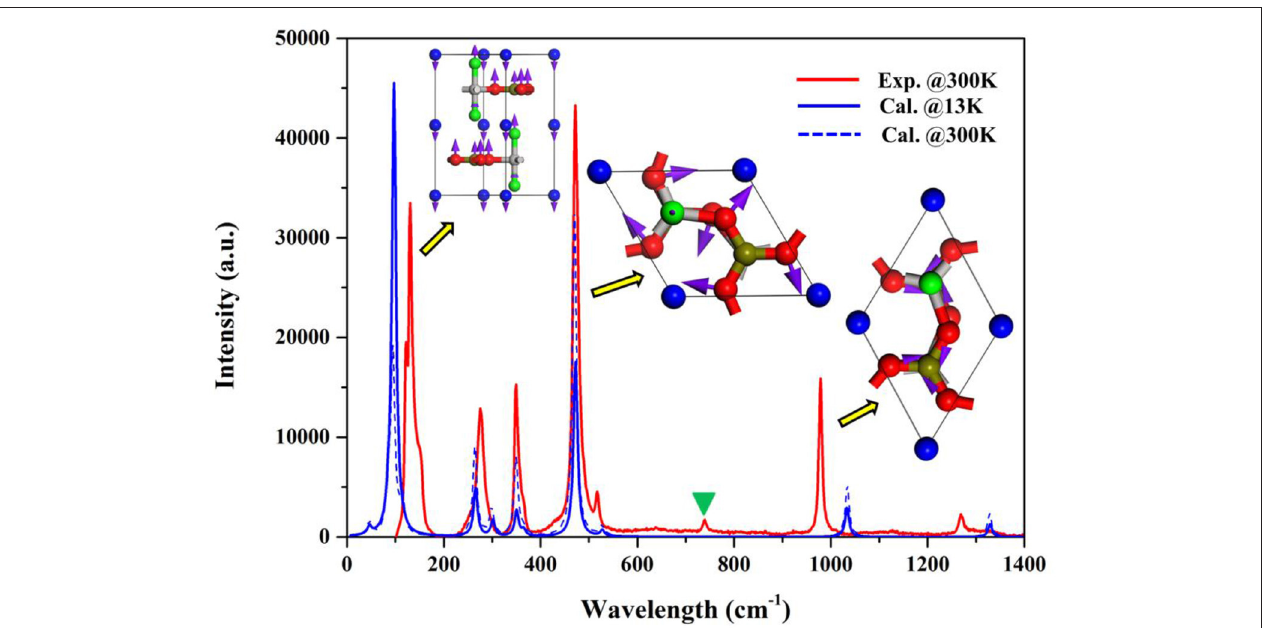
FIGURE 4 | Measured and calculated Raman spectrum of BABF. The modes with the highest peaks at 87, 473, and 1,030 cm − 1 are used to schematically describe the atomic vibration of type-I, II, and III phonon modes respectively. The peaks at around 720cm − 1 labeled by green triangle in the experimental spectrum is attributed to the impurity.